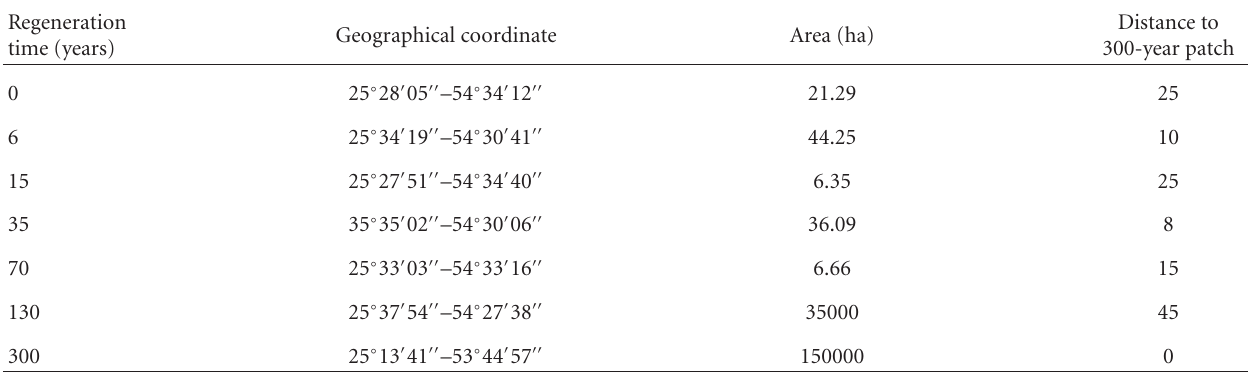
Table 1: Characteristics of the sampled forest patches. Geographical coordinates correspond to the central point in each patch. Regeneration Geographical coordinate Area (ha) time (years)